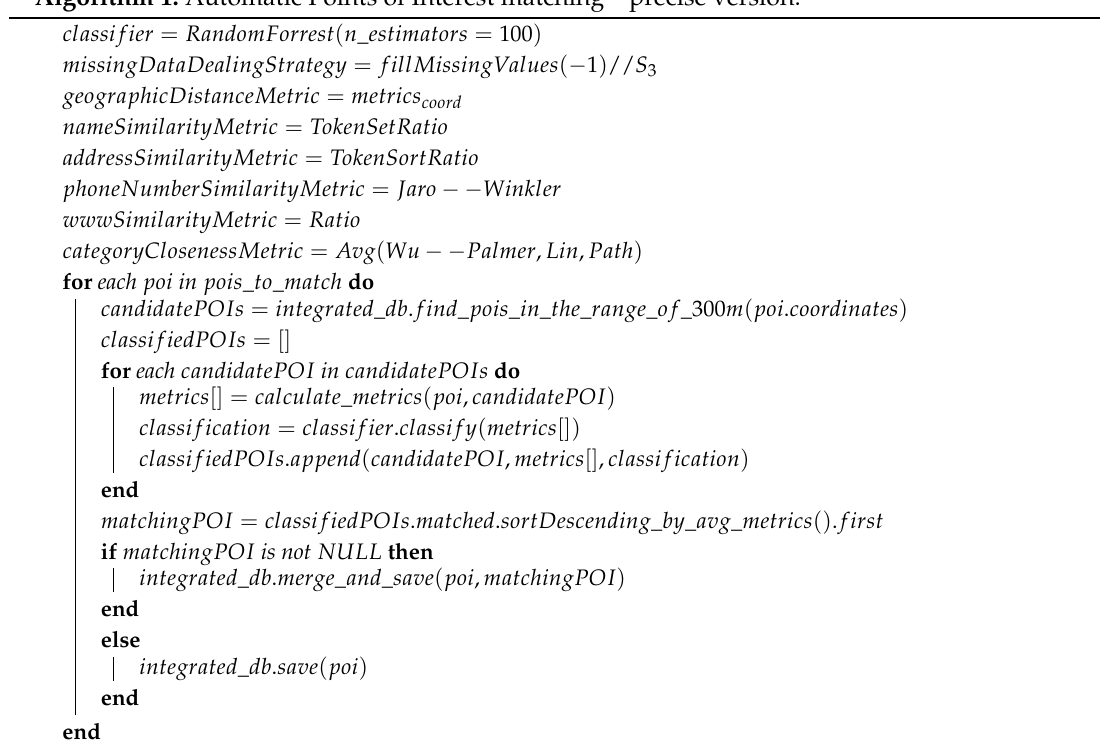
Algorithm 1: Automatic Points of Interest matching—precise